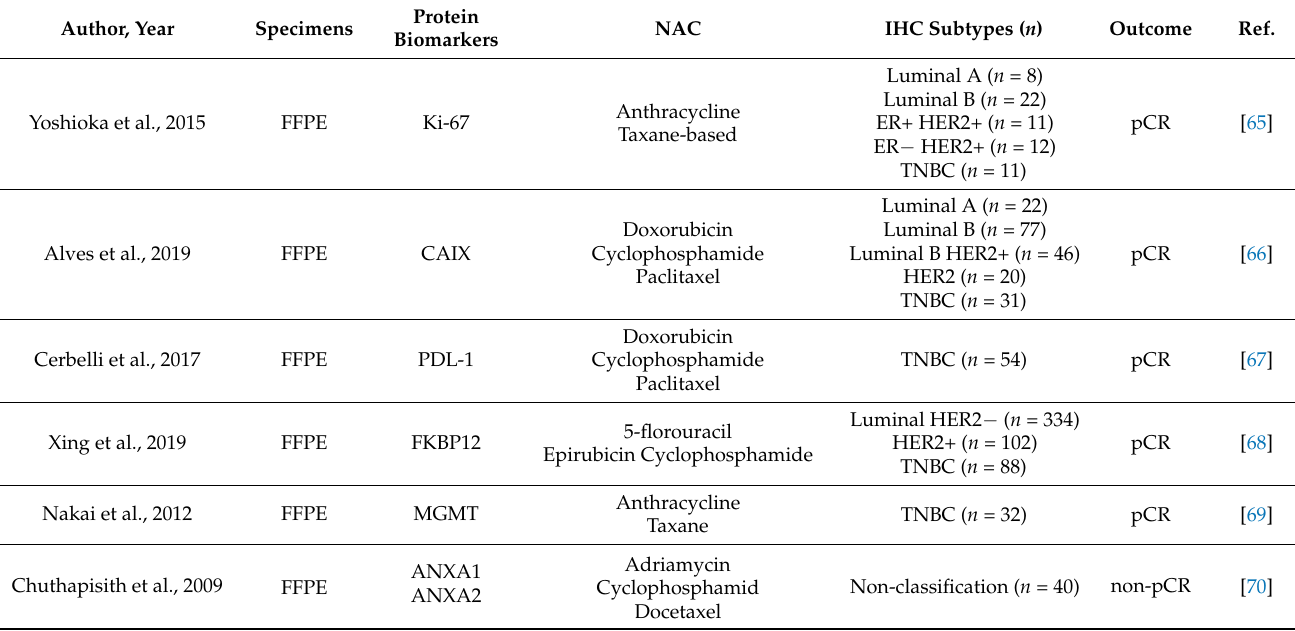
Table 5. Proteins as biomarkers of pCR or non-pCR after NAC in BC